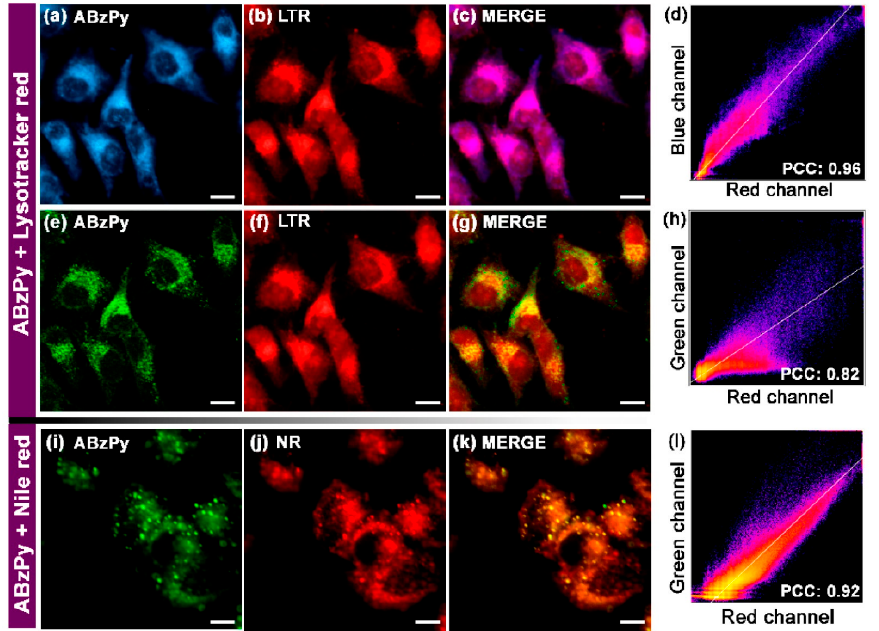
Figure 13. Fluorescence microscopy images of HeLa cells ( a – c , e – g ) incubated with the aqueous dispersion of C19 (represented as “ ABzPy ” in the original report) and lysotracker red (LTR) for 30 min: ( a ) DAPI filter (blue channel, λ ex = 335–383 nm, λ em = 420–470 nm; C19 ), ( b ) DsRed filter (red channel, λ ex = 538–562 nm, λ em = 570–640 nm; LTR), ( c ) merged image of panels ( a , b ) and ( d ) the colocalization plot of red channel (LTR) vs. blue channel ( C19 ) with Pearson’s coefficient of colocalization (PCC) value of 0.96 depicting specific targeting of lysosomes by C19 . ( e ) GFP filter (green channel, λ ex = 450–490 nm, λ em = 500–550 nm; C19 ), ( f ) DsRed filter (red channel, λ ex = 538–562 nm, λ em = 570–640 nm; LTR), ( g ) merged image of panels ( e , f ) and ( h ) the colocalization plot of red channel (LTR) vs. green channel ( C19 ) with PCC value of 0.82 depicting the reduced level of colocalization. Fluorescence microscopy images of HeLa cells ( i – k ) incubated with the aqueous dispersion of C19 and Nile red (NR, a lipid droplet tracker dye) for 30 min: ( i ) GFP filter (green channel, λ ex = 450–490 nm, λ em = 500–550 nm; C19 ), ( j ) DsRed filter (red channel, λ ex = 538–562 nm, λ em = 570–640 nm; NR), ( k ) merged image of panels ( i , j ) and ( l ) the colocalization plot of red channel (NR) vs. green channel ( C19 ) with PCC value of 0.92 depicting specific targeting ability of C19 to lipid droplets. Scale = 10 µm (Reproduced with the permission from Ref. [86]).